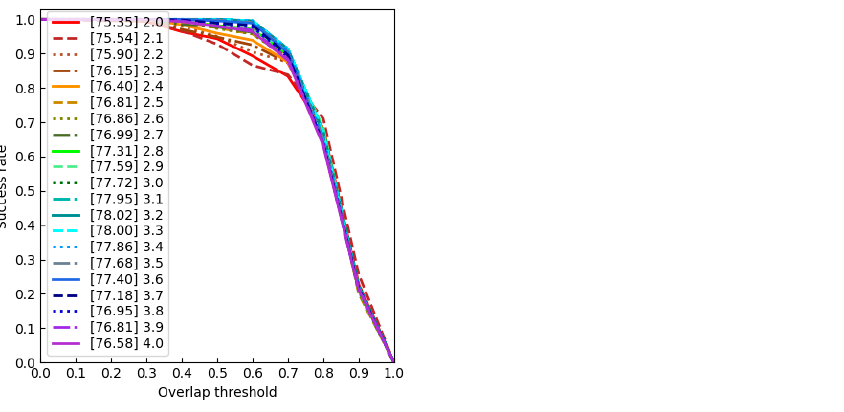
Figure 10. Success plot for per threshold and the legend is the AUC per threshold.